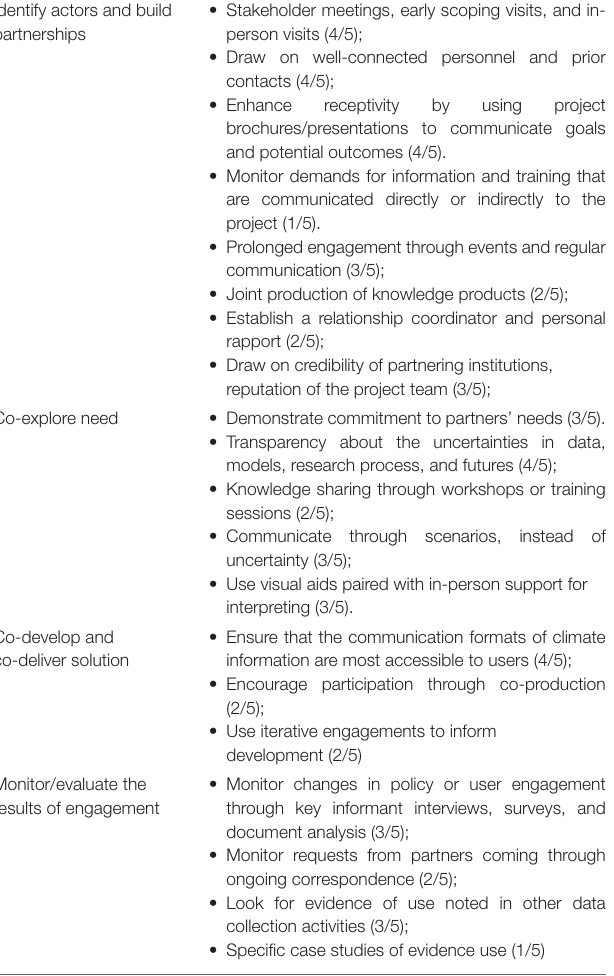
TABLE 2 | User engagement strategies highlighted by FCFA consortia mapped to stages of co-production. Identify actors and build